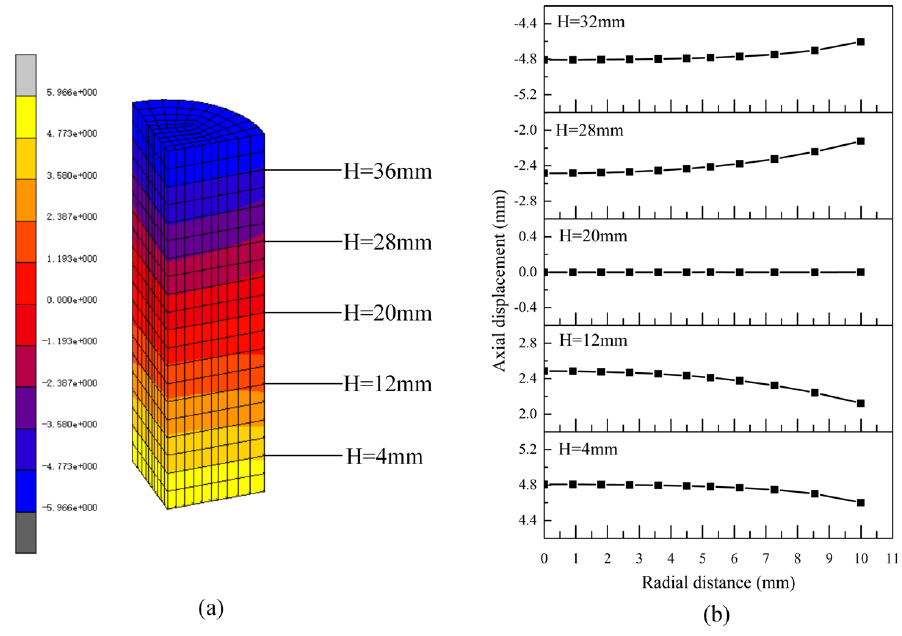
Figure 20. Axial displacement distribution in powder compact at μ = 0.2 in ( a ) displacement contours and ( b ) displacement at different compact heights.